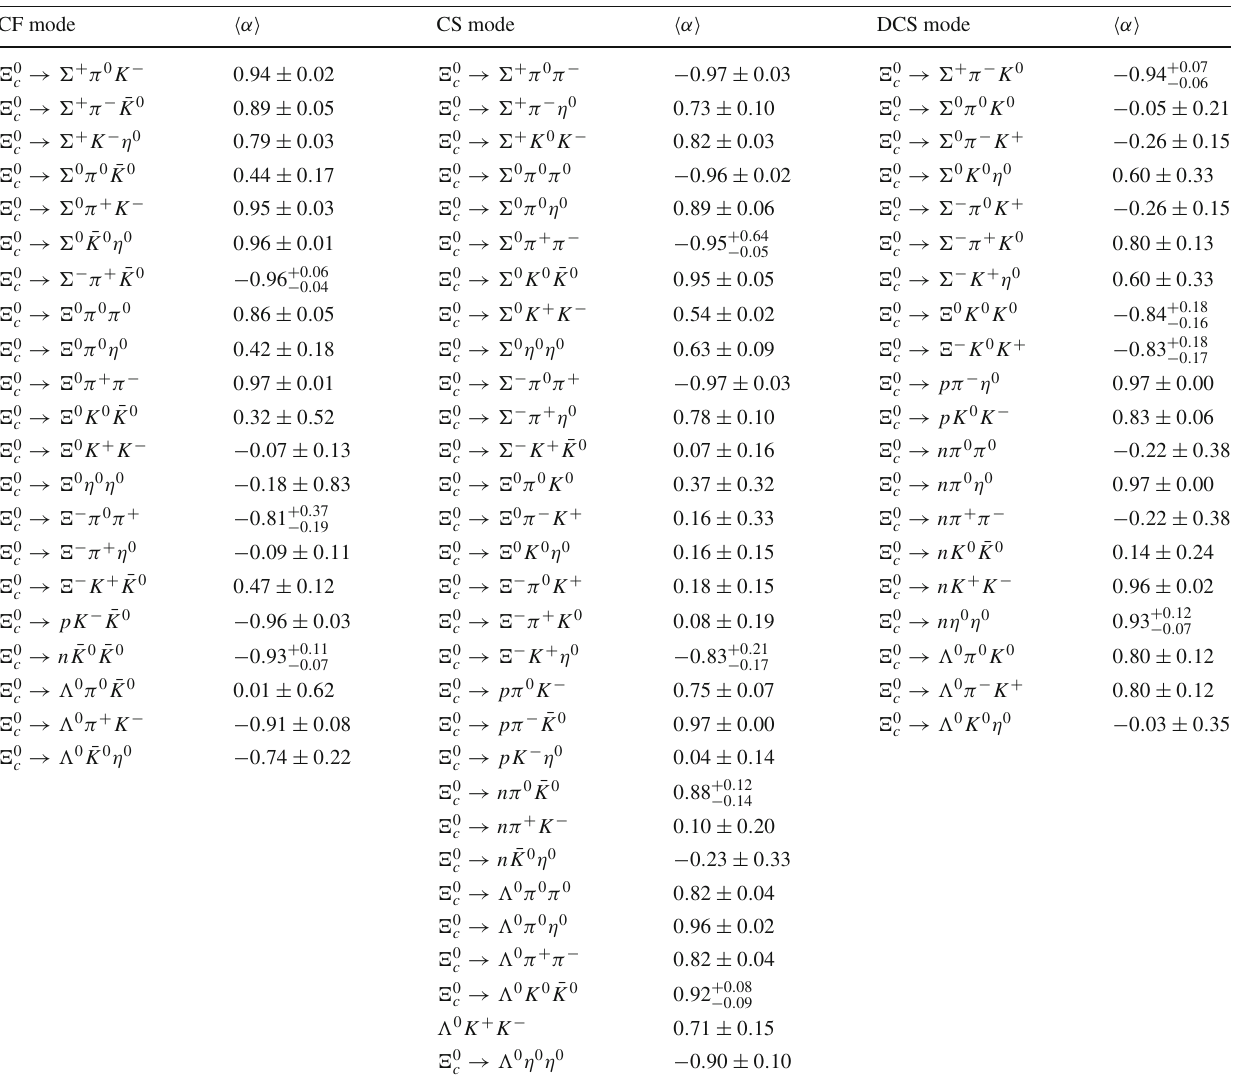
Table 11 Numerical results for (cid:8) α (cid:9) ((cid:2) 0 c → B n MM (cid:3) ) CF